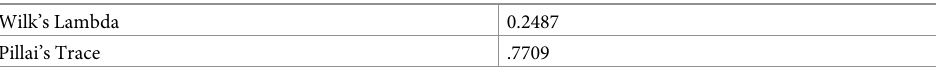
Table 3. Test statistics.